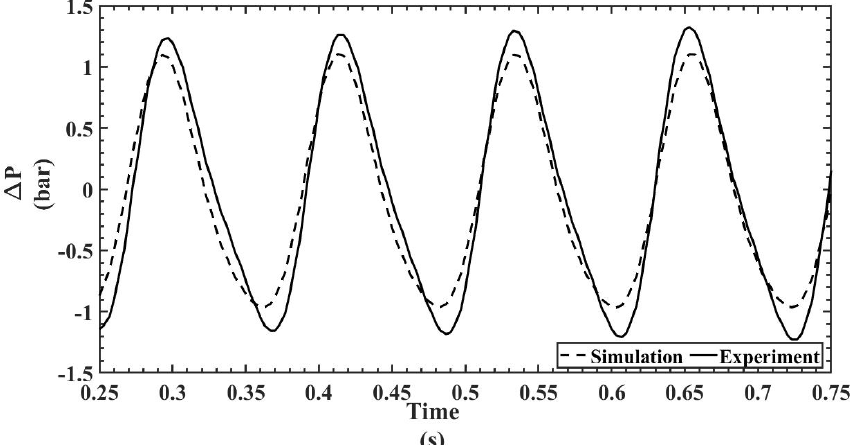
Figure 20. Temporal pressure drop for a 300 mesh regenerator at 500 RPM.